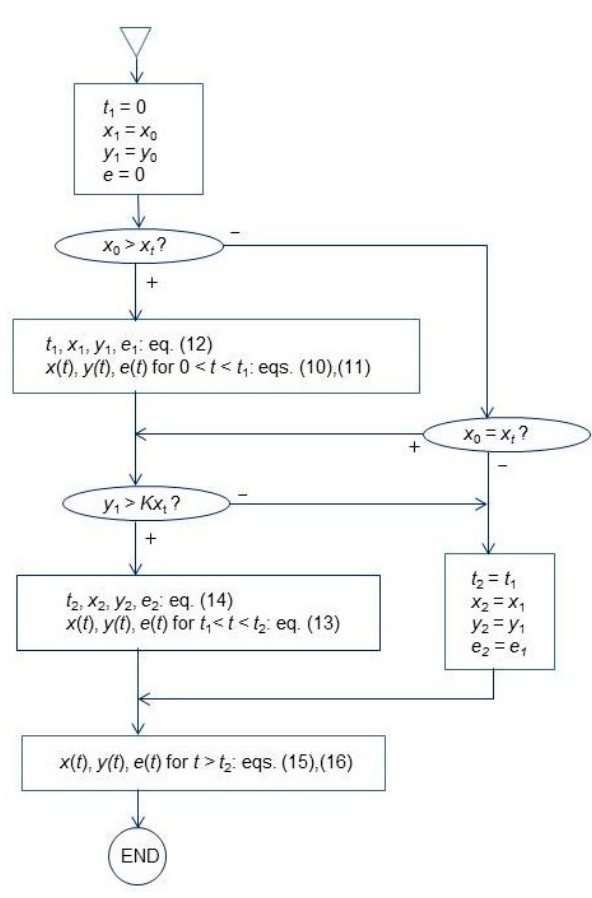
Figure 5. Algorithm of the lumped parameter model solution.